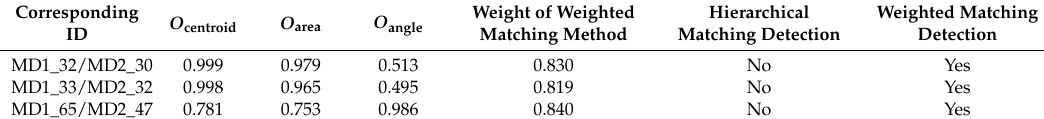
Table 3. Matching analysis of object instances.